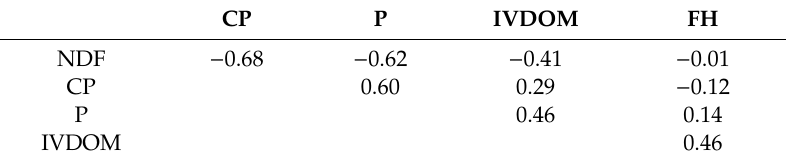
Table2. Pearsongeneticcorrelationsamongforageharvested(FH)andnutritivevaluetraits: CP—Crude Protein concentration, P—Phosphorus concentration, IVDOM—In Vitro Digestible Organic Matter, and NDF—Neutral Detergent Fiber; estimated for the USDA-NPGS bermudagrass germplasm collection and checks: Tifton 85, Jiggs and Florida 44, evaluated in Citra, FL. Color code: red and blue indicate